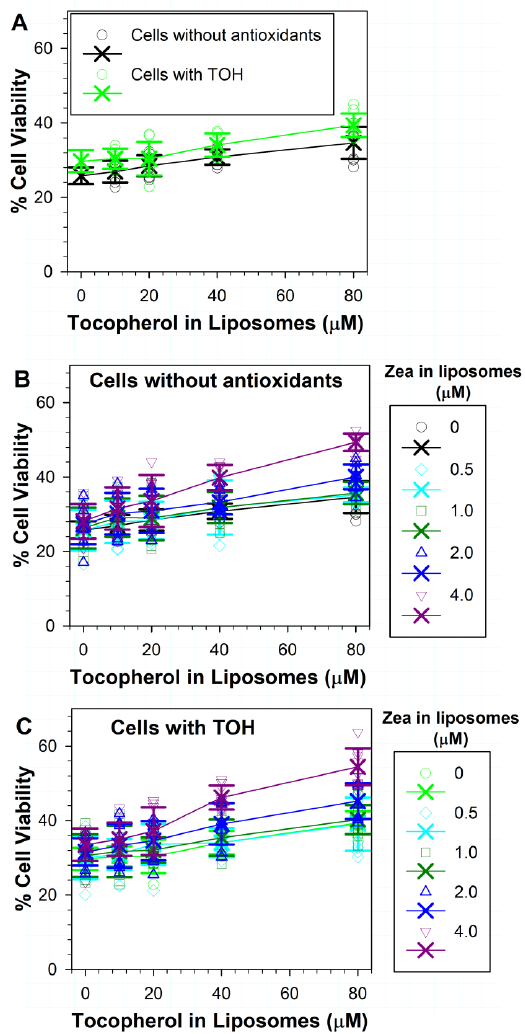
Figure 5. ( A ) Effects on phototoxicity of different concentrations of α -tocopherol in liposomes to ARPE-19 cells supplemented with α -tocopherol (TOH) and without α -tocopherol. ( B ) Effects on phototoxicity of different combinations of zeaxanthin (Zea) and α -tocopherol in liposomes to ARPE- 19 cells not supplemented with antioxidants (the data are the same as in Figure 4B, plotted here as a function of α -tocopherol concentration). ( C ) Effects on phototoxicity of different combinations of zeaxanthin and α -tocopherol in liposomes to ARPE- 19 cells supplemented with α -tocopherol. The symbols represent the viability of cells in independent experiments, the crosses represent the means, while the error bars show SDs (the individual data points from experiments with no antioxidants in liposomes are shown only in Figure 3; N for each experiment with antioxidants in liposomes was 8). Other experimental conditions as in Figure 3.